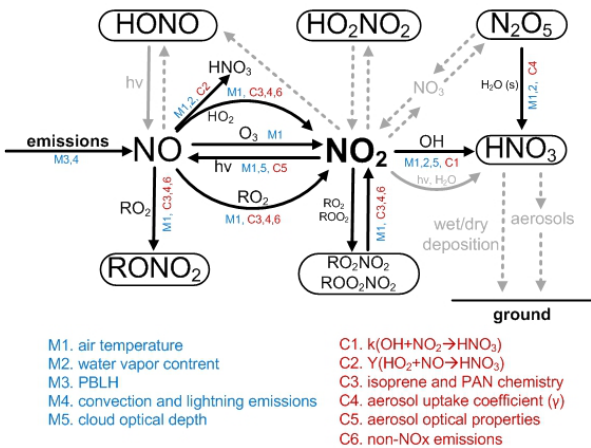
Fig. 1. Tropospheric chemistry involving NO x and impacts of mete- orological and chemical parameters evaluated in the present study. Processes shown in solid grey arrows are discussed without sensi- tivity simulations. Processes shown in dashed grey arrows are not discussed explicitly. Note that PBL mixing and convection affect vertical distributions of NO x and related species. Heterogeneous uptake on aerosols depends on the amount of aerosol surfaces as well. Evaluation on the RONO 2 pathway is focused mainly on iso- prene nitrates. Clouds and water vapor have indirect influences on radicals through effects on solar